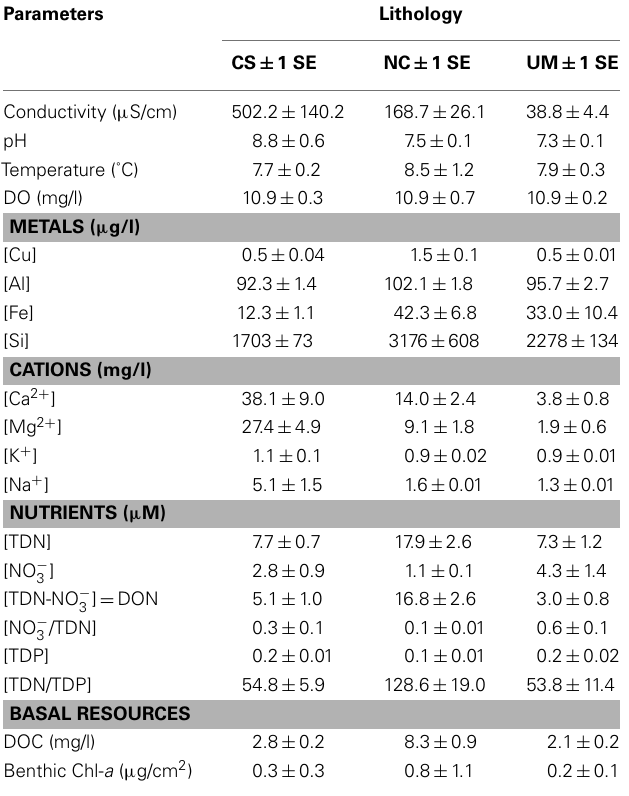
Table 1 |Values of biological, chemical, and physical parameters for study streams by lithology (CS, Complex Sedimentary; NC, Non-carbonate; UM, Ultramafic).